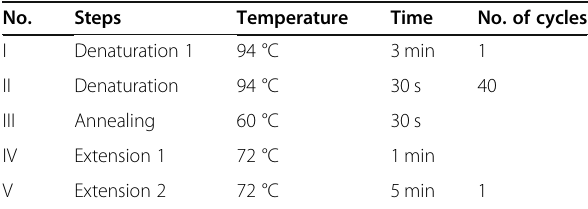
Table 5 Real-time PCR program